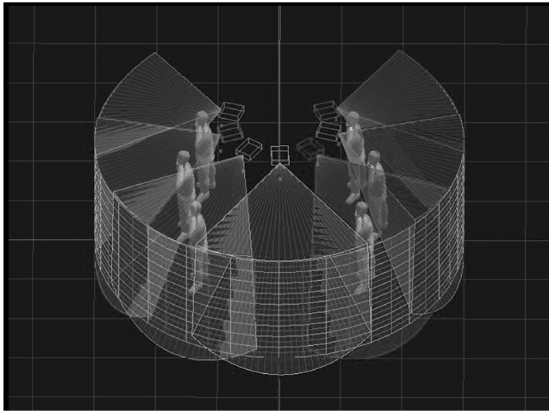
Figure 1. SimuScape © with 270°-panoramic